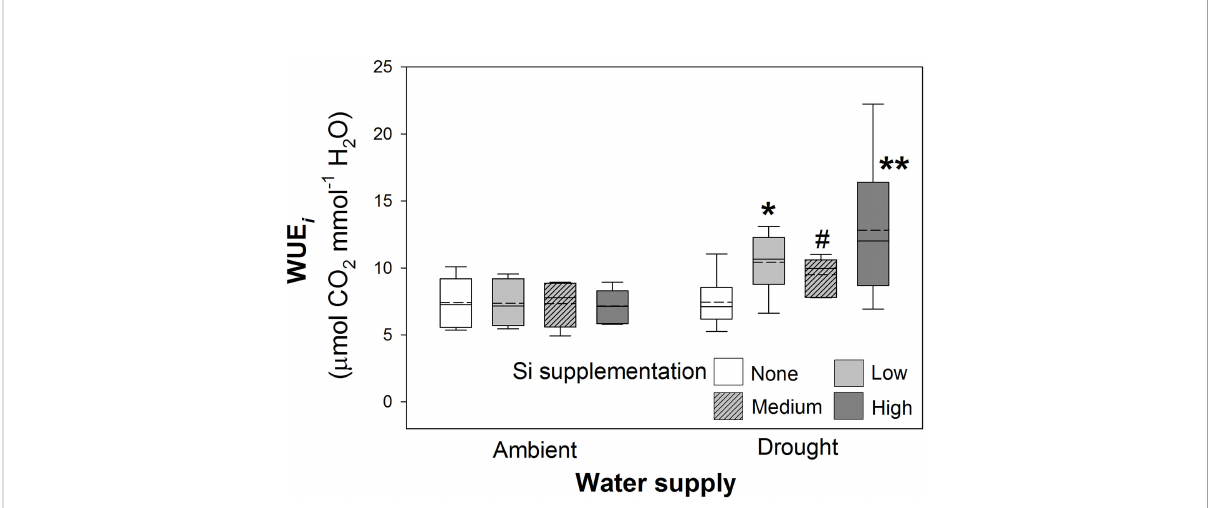
FIGURE 6 Instantaneous water use ef fi ciency (WUE i ) of plants grown with Si supplementation (low, medium and high; 39, 78 and 117 kg ha -1 ) compared to plants without Si supplementation (none) under ambient and drought conditions (details as in Figure 2; N = 6). Statistically signi fi cant differences between Si supplemented plants and non-supplemented plants indicated * P < 0.05 and ** P < 0.01. Marginal non-signi fi cance ( P < 0.10) at the 95% con fi dence interval indicated